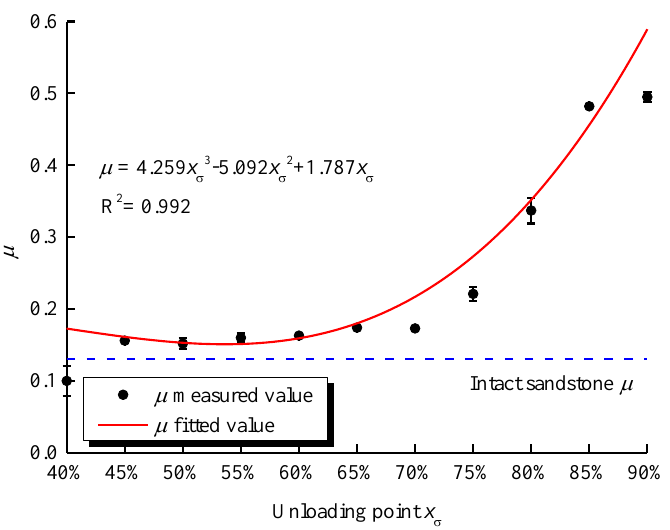
Figure 5. Relationship curve between Poisson ’s ratio μ and unloading point x σ .